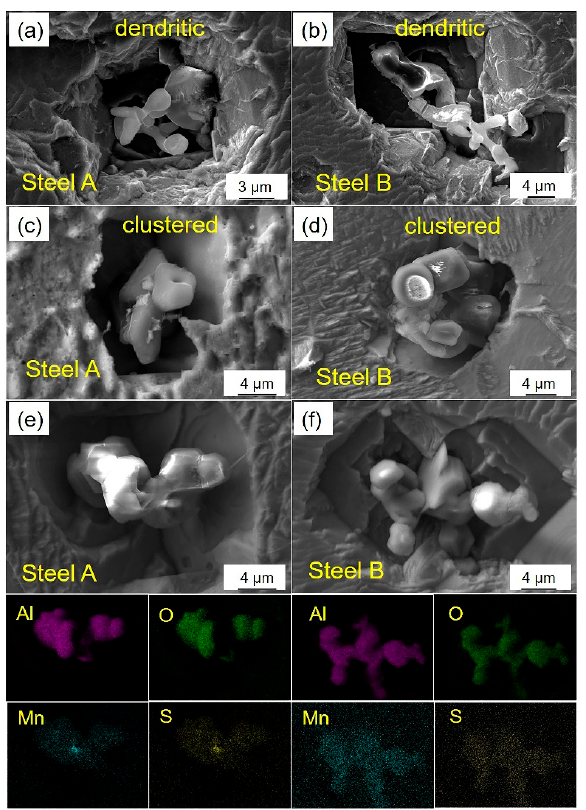
Figure 7. Typical morphologies of inclusions in the slab for Steels A and B: ( a – d ) Al 2 O 3 and ( e, f ) Al 2 O 3 - MnS, as well as the map scanning results of element distribution for (e) and (f).